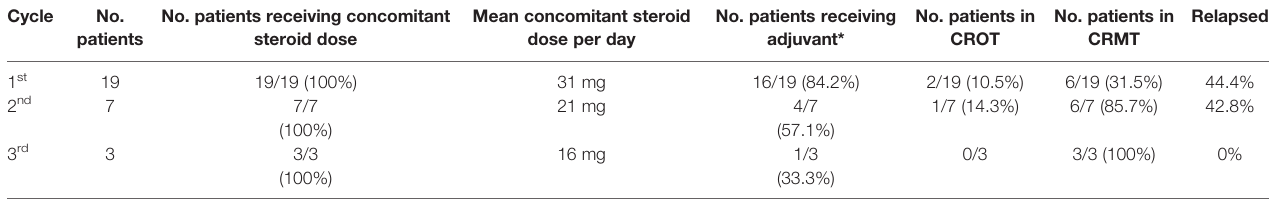
TABLE 2 | Concomitant therapy during each rituximab cycle with patient outcomes. Cycle